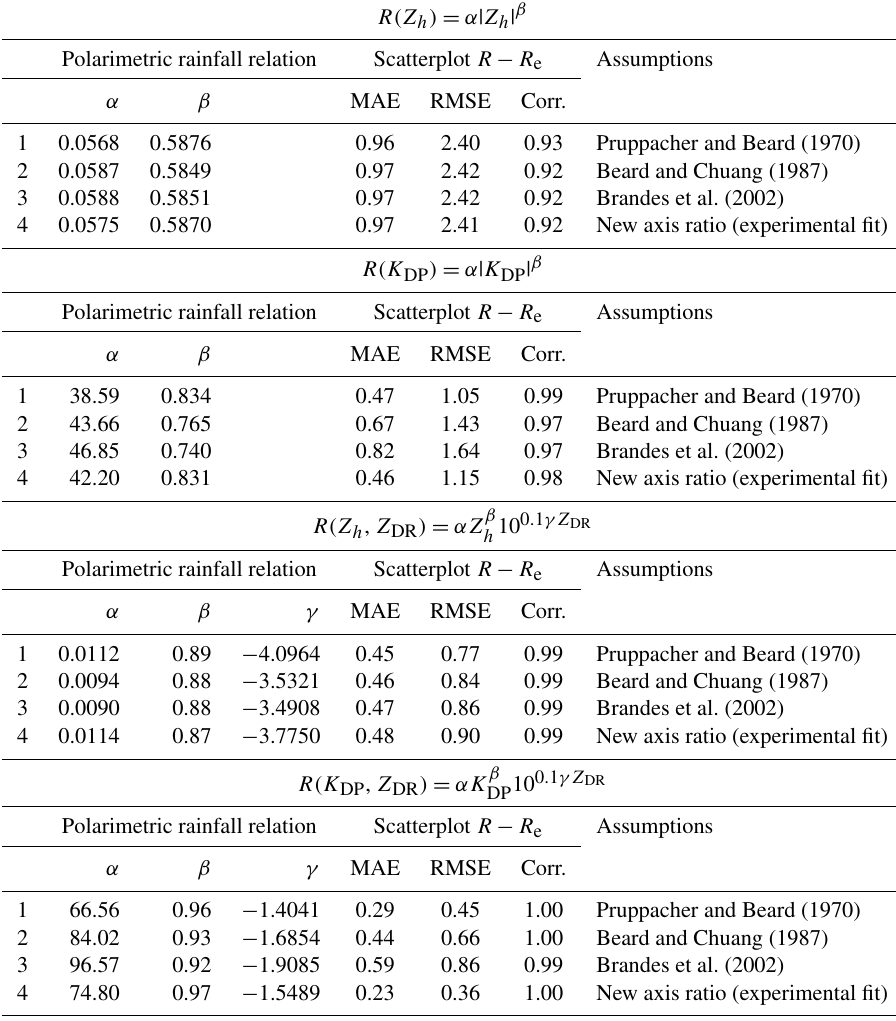
Table 3. List of different polarimetric rainfall relations used for rainfall estimations and the mean absolute error (MAE), root-mean-square error (RMSE), and correlation coefficient for estimated rain rates vs.